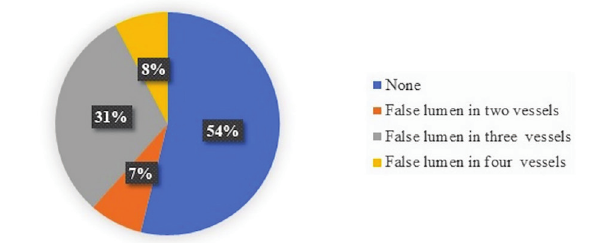
Figure 6 - Distribution of patients in terms of false